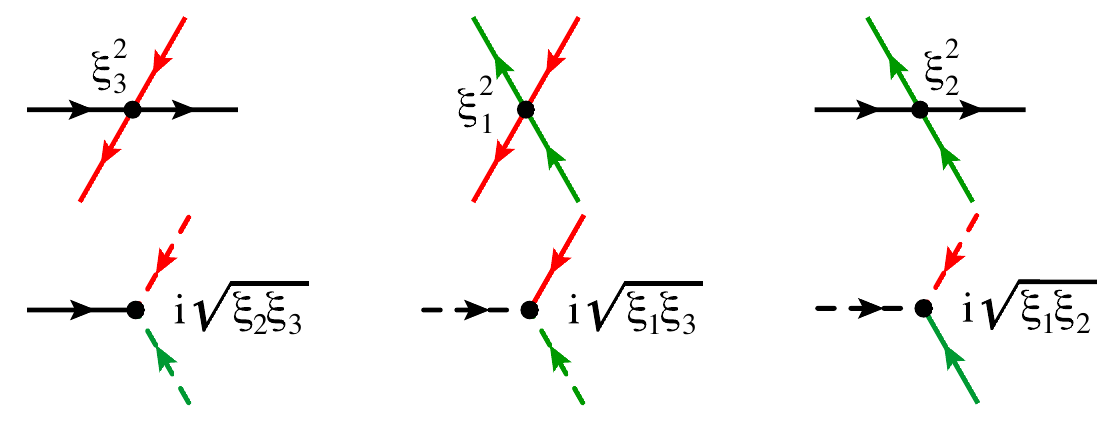
Figure 1 . The chiral vertices of the DS theory (2.2). The graphs of the (cid:12)rst line represent the quartic scalar interactions and the ones in the second line are the Yukawa interactions. Tick solid lines and dashed lines represent scalar and fermionic propagators respectively. Colors stand for the various \(cid:13)avour" of the particles (cid:30) i and i : black for i = 1, red for i = 2 and green for i = 3. Arrows symbolize the (cid:12)xed orientation (chirality) of the vertices and, according to our notation, it points always to the (cid:12)elds with bars or daggers. The second chirality of Yukawa interactions i.e. the one with (cid:22) i ! i and (cid:30) y ! (cid:30) i with i = 1 ; 2 ; 3, can be represented as the second line of vertices i with (cid:13)ipped